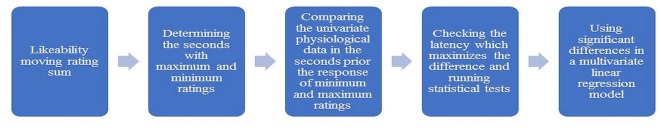
Physiological data processing and analysis.